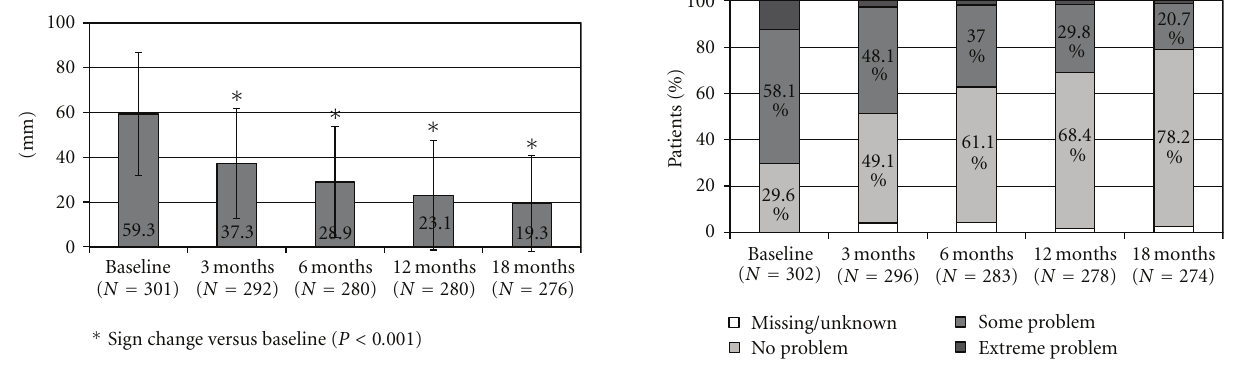
Figure 5: EQ-5D: usual